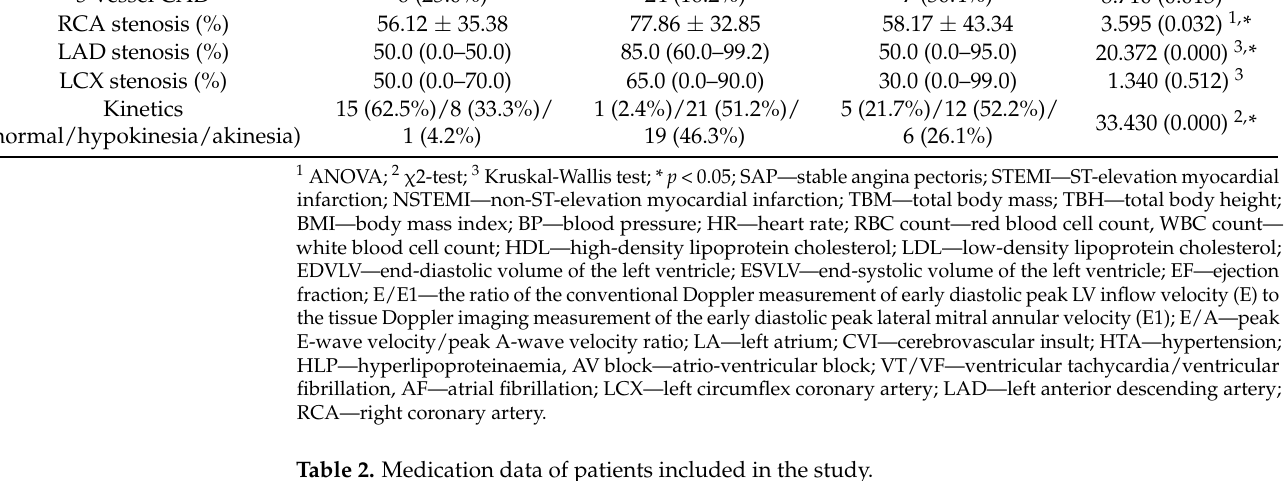
Table 2. Medication data of patients included in the study.